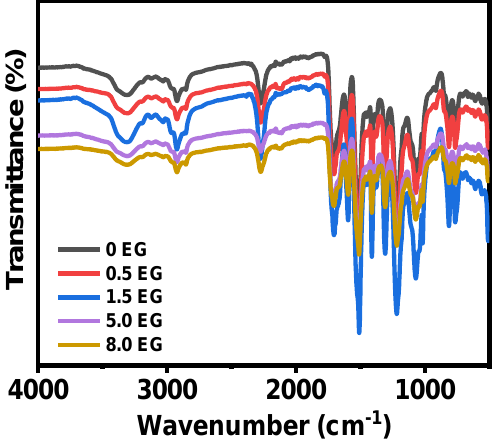
Figure 6. Closed-cell content of polyurethane foams with carvone-based polyol with an increasing amount of EG.